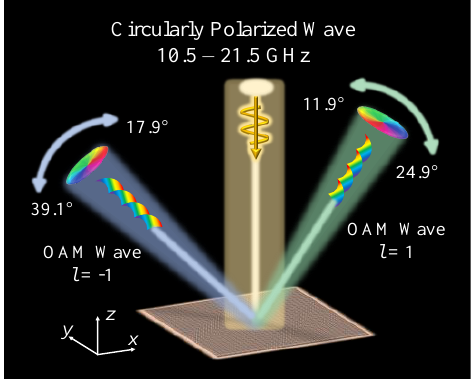
Figure 1. Schematic diagram of the proposed frequency scanning dual-mode asymmetric dual-OAM-wave metasurface.